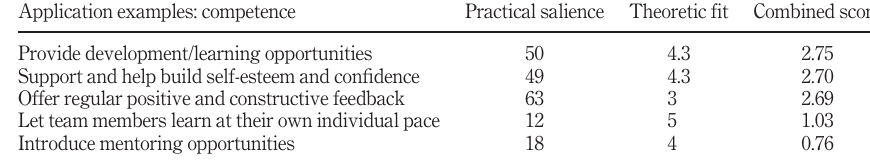
Table 2. How leaders support followers ’ basic psychological need for competence in the